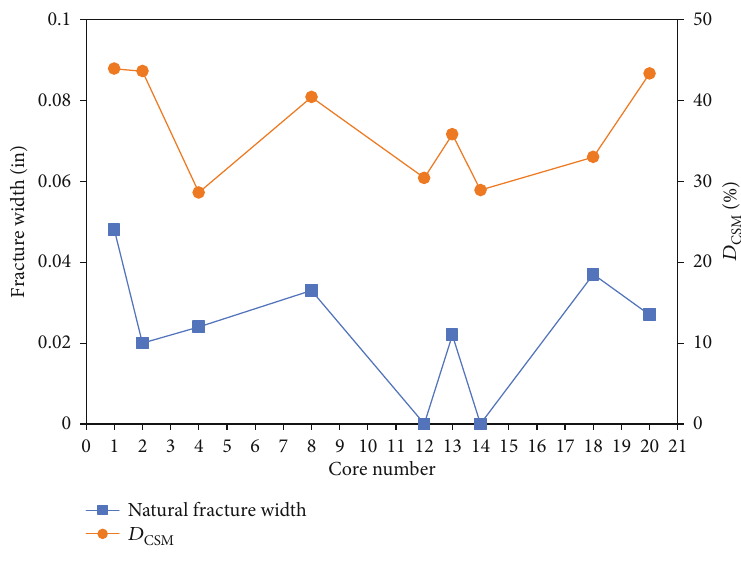
Figure 8: CSM damage of the tight sandstone core.